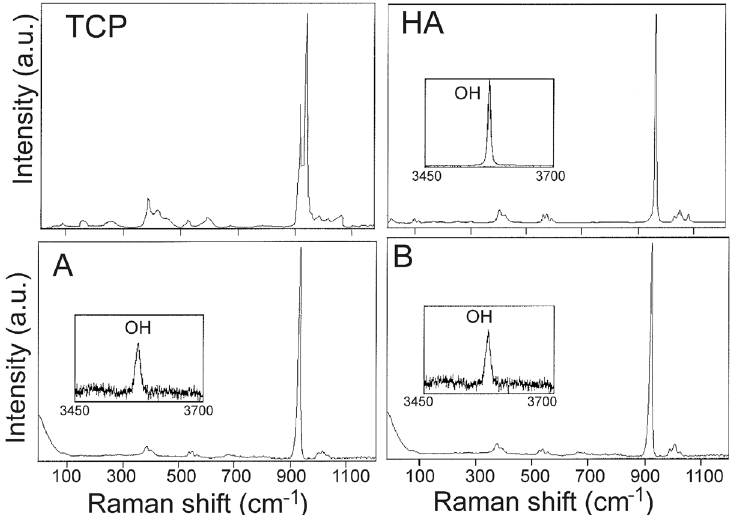
Figure 9. ( A , B ) Micro-Raman spectra of the reaction zone after 15 months of implantation. Micro-Raman spectra of Standard TCP and HA is also included.